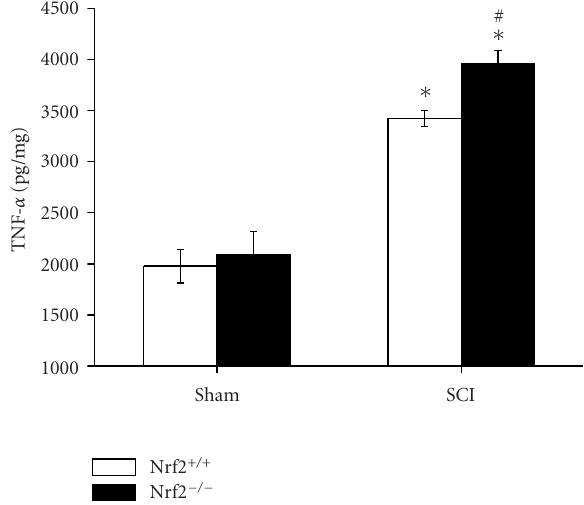
Figure 5: Protein expression levels of TNF- α in spinal cord samples of sham and injured Nrf2 (+/+) and Nrf2 ( − / − ) mice. The figure indicates that spinal cord contents of TNF- α were significantly increased and were higher in Nrf2 ( − / − ) mice than in Nrf2 (+/+) mice at 24 hours after SCI. Bars represent mean ± S.E. ( n = 6, each group). ∗ P < . 01 versus genotype-matched sham-operated mice. #